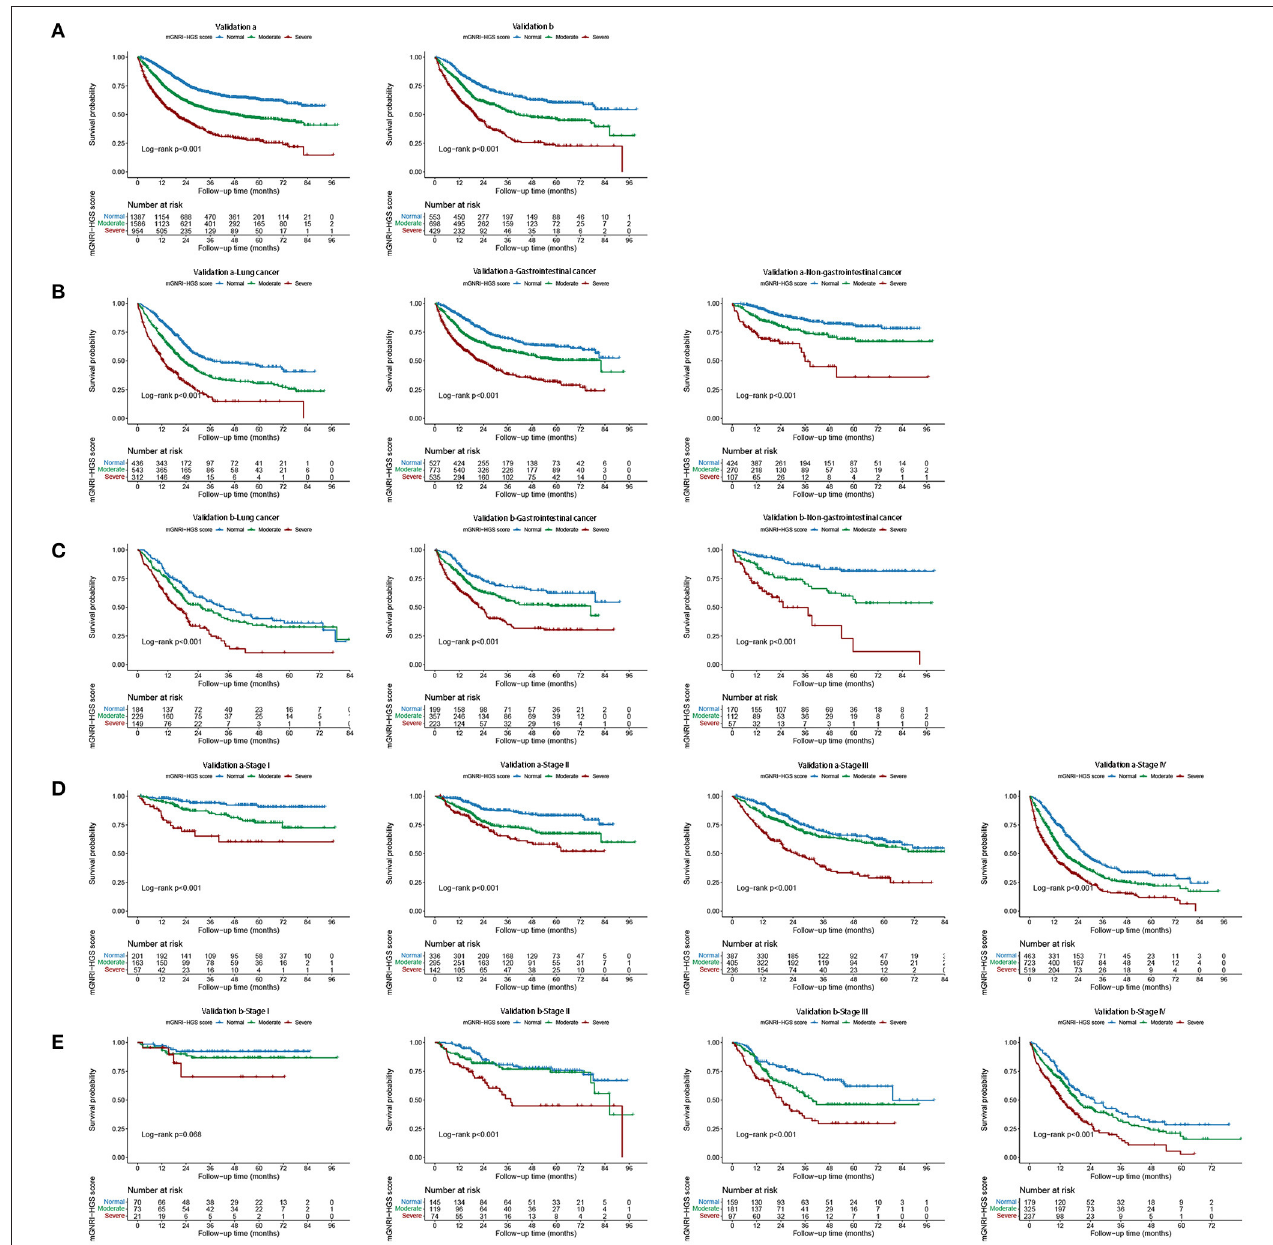
FIGURE 3 | Internal validation of mGNRI-HGS score based different tumor types and pathological stages. (A) Internal validation of mGNRI-HGS score; (B) Internal validation a of mGNRI-HGS score based on tumor types; (C) Internal validation b of mGNRI-HGS score based on tumor types; (D) Internal validation a